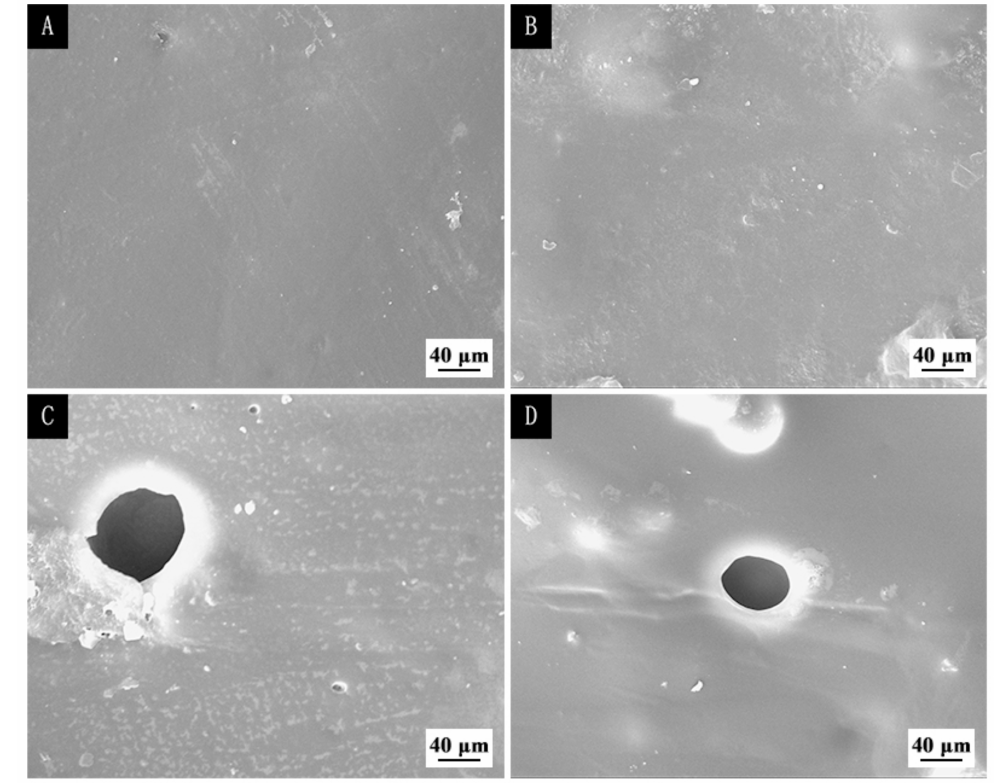
Figure 10. The SEM of waterborne primer film with different concentration of microcapsules (600 rpm stirring rate) before and after aging: before aging, ( A ) 0%, ( B ) 5.0%, after aging, ( C ) 0%, ( D )